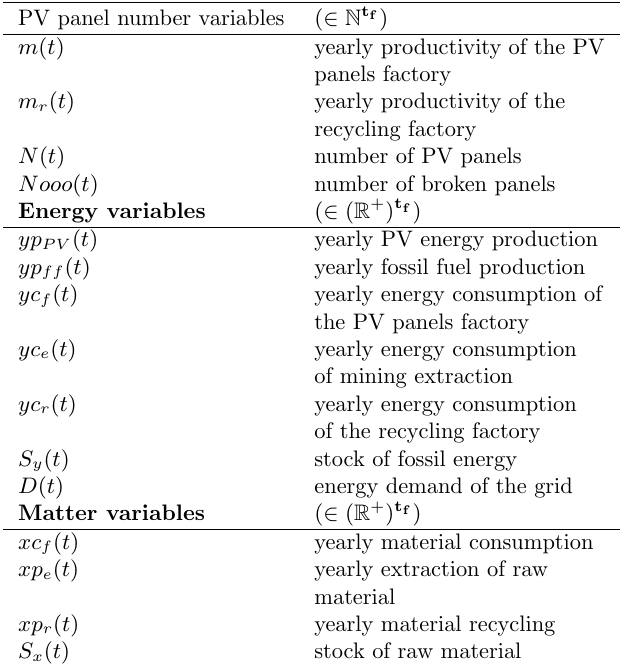
Fig. 1. Modular diagram representing interactions between PV panels factory, matter and energy stocks, and energy mix. The recycling module is surrounded in a green frame, its implementa- tion depends on the chosen scenario to run. Same for grid energy demand D ( t ) . Table 1. Discrete variables of the model depending on 0 , t f time t ∈ , with t f a positive integer as the time (cid:74) (cid:75) horizon of a